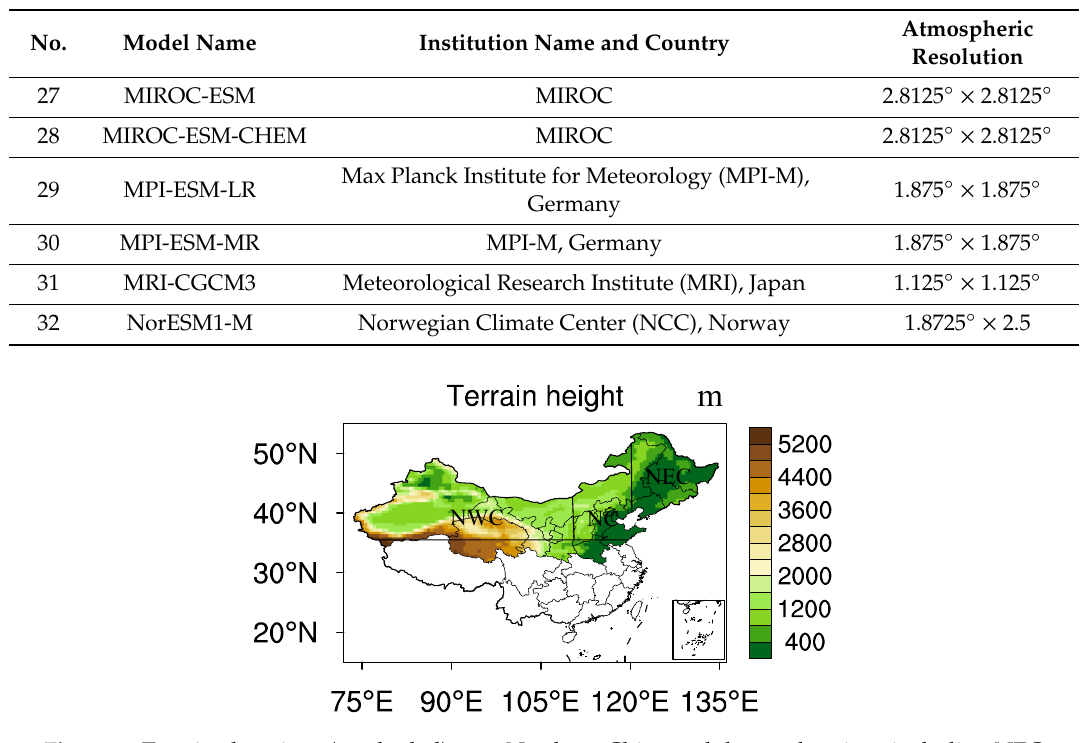
Figure 1. Terrain elevations (m, shaded) over Northern China and three subregions including NEC (Northeast China), NC (North China), and NWC (Northwest China).